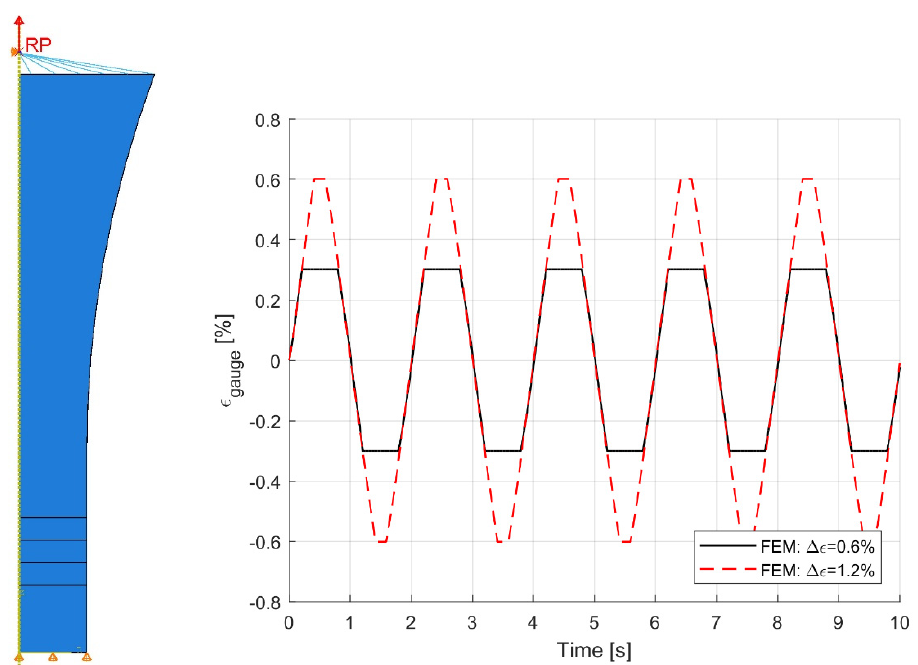
Figure 5. Load and boundary conditions.